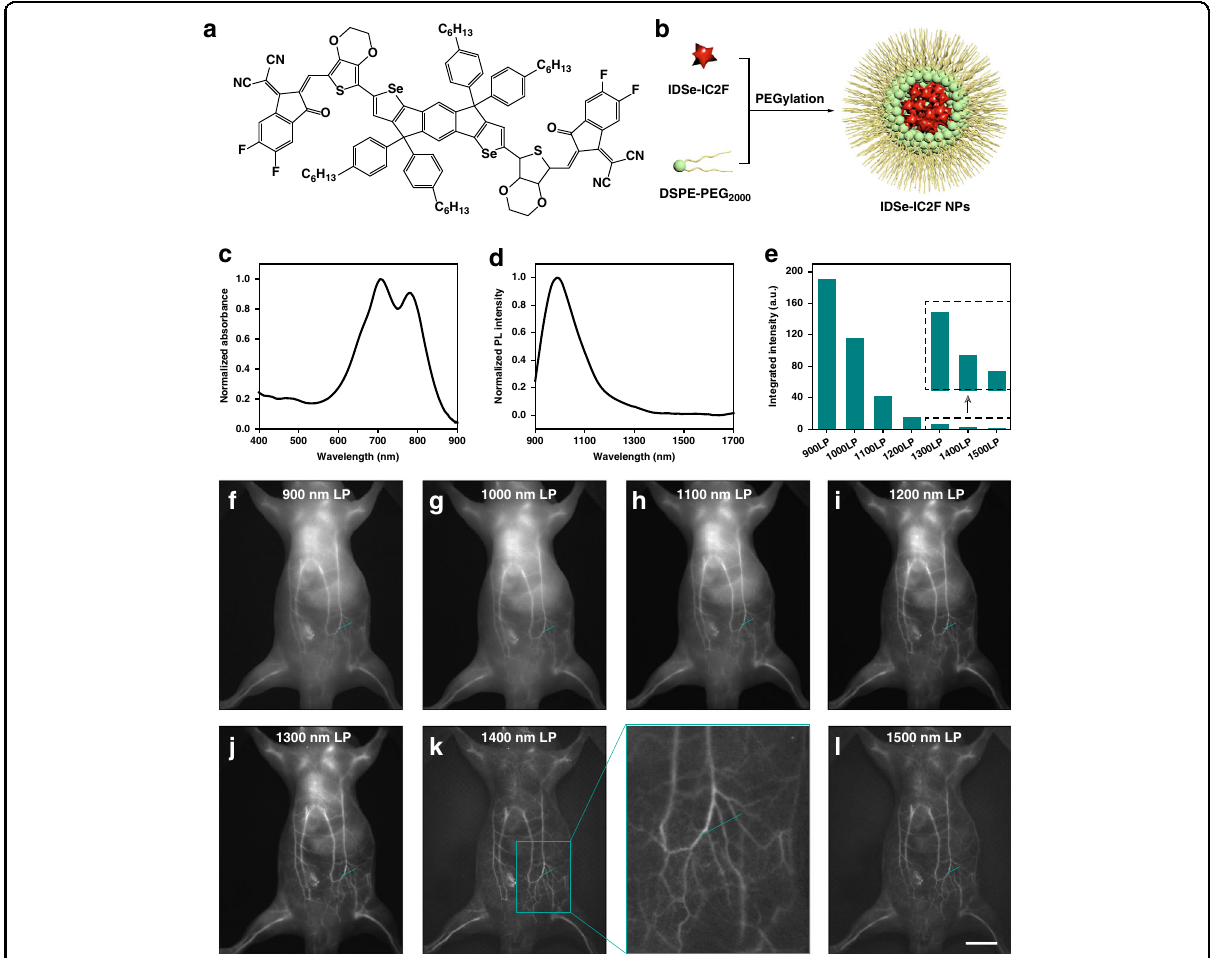
Fig. 8 In vivo fl uorescence imaging of mice using the emission tail of the probes. a The molecular structure of IDSe-IC2F. b The schematic illustration of the synthesis of IDSe-IC2F NPs. The normalized ( c ) absorbance and ( d ) emission spectra of IDSe-IC2F NPs. ( e ) The integrated emission intensities in 900 – 1700, 1000 – 1700, 1100 – 1700, 1200 – 1700, 1300 – 1700, 1400 – 1700, and 1500 – 1700 nm regions. The whole-body fl uorescence imaging of the same mouse beyond ( f ) 900 nm, ( g ) 1000 nm, ( h ) 1100 nm, ( i ) 1200 nm, ( j ) 1300 nm, ( k ) 1400 nm, and ( l ) 1500 nm. m Cross-sectional fl uorescence intensity pro fi les along the indigo lines of the blood vessel in ( f – l ). The numbers show the SBRs. The hind limb fl uorescence imaging of the same mouse beyond ( n ) 900 nm, ( o ) 1000 nm, ( p ) 1100 nm, ( q ) 1200 nm, ( r ) 1300 nm, ( s ) 1400 nm, and ( t ) 1500 nm. u Cross-sectional fl uorescence intensity pro fi les along the indigo lines of the blood vessel in ( n – t ). The numbers show the SBRs. The whole-body fl uorescence imaging of the same mouse beyond ( v ) 1300 nm, ( w ) 1400 nm, and ( x ) 1500 nm, after the NPs accumulated in the liver. y The fl uorescence intensity pro fi les along the indigo lines of the blood vessel above the liver in ( v – x ). The numbers show the SBRs. Scale bars: 10